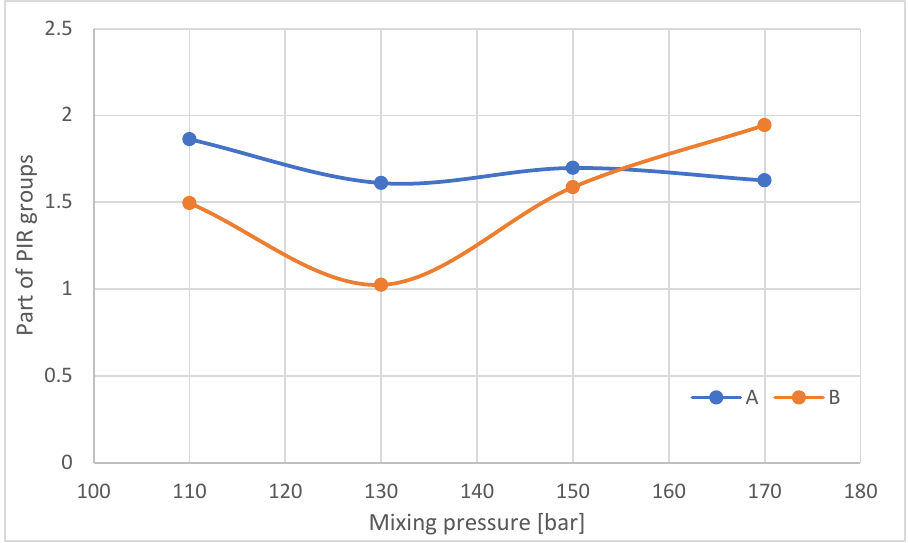
Figure 19. Proportion of PIR groups in samples taken from parts A and B of the foam blocks. The effect of viscosity on the PIR contribution and friability of the foams from the central part of the blocks was analyzed (Figure 20). Viscosity was calculated by matching the temperature of the polyol at the time of pouring with the viscosity of the polyol measured at different measurement temperatures according to Brookfield’s method.